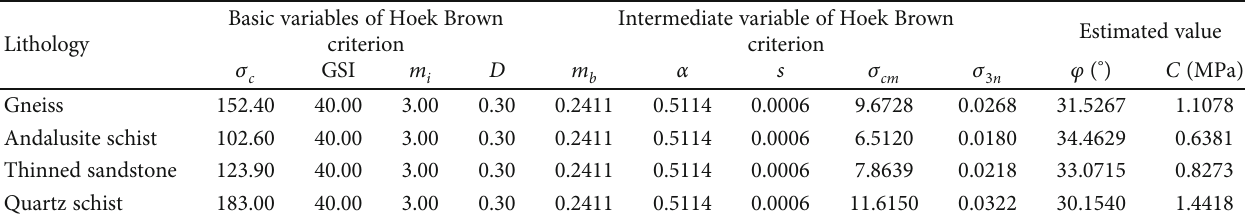
Table 3: Hoek-Brown criterion for estimating slope strength